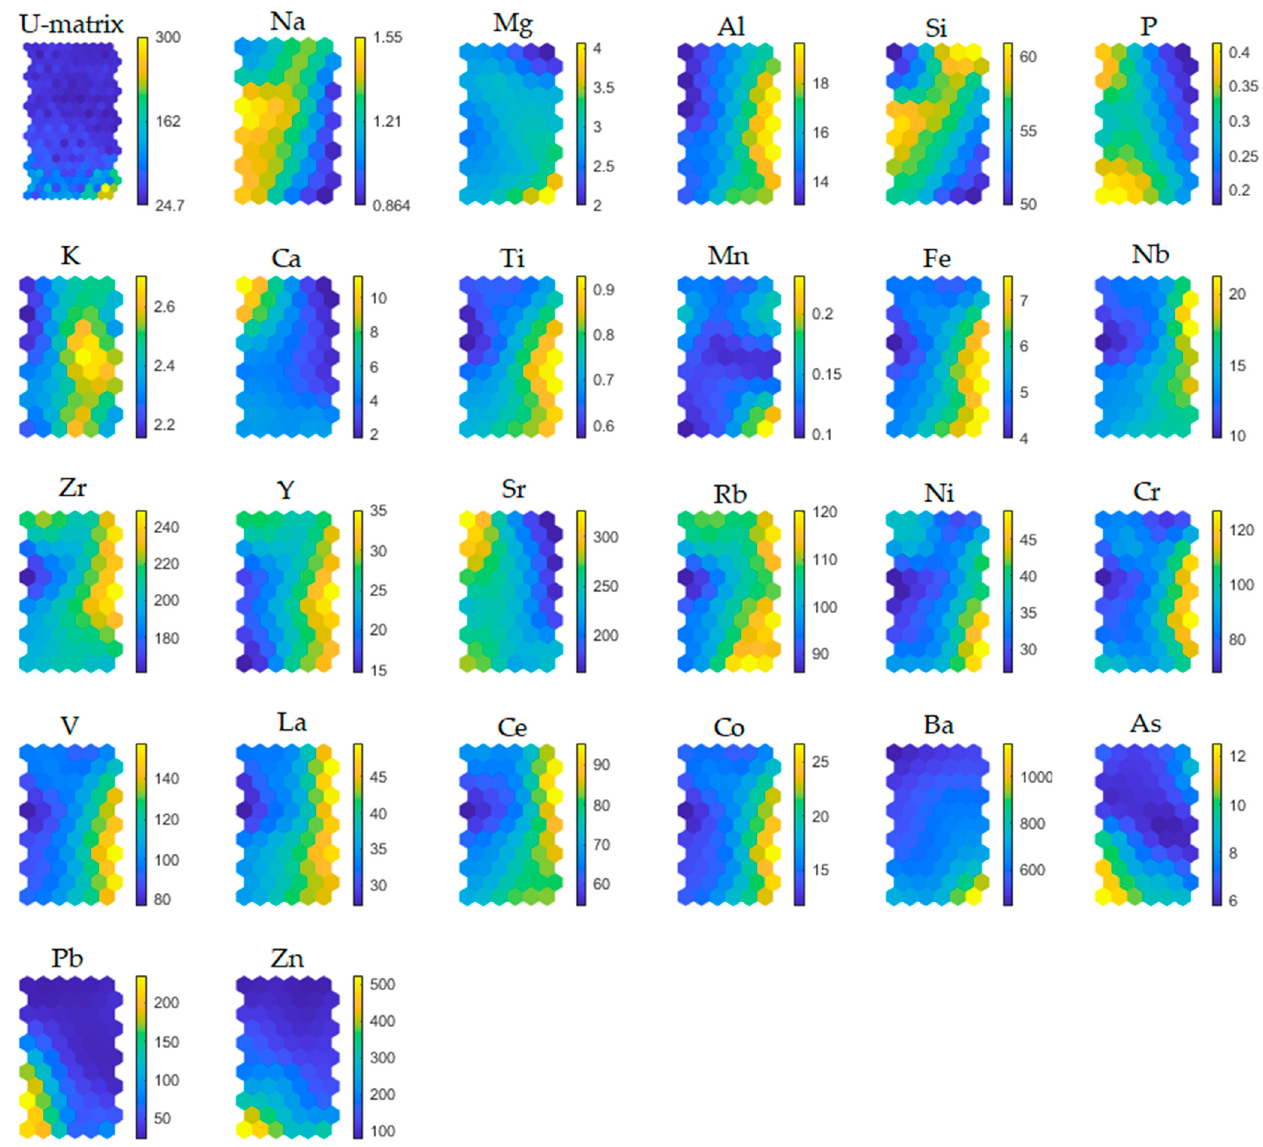
Figure 2. Component planes for all sampling sites and parameters. U-matrix visualizes distances between neighbouring map units and helps to identify the cluster structure of the map. High values of the U-matrix indicate a cluster border, uniform areas of low values indicate clusters themselves; each component plane shows the values of one variable in each map unit. Both grey-tone pattern and grey-tone bar labelled as “d” deliver information regarding compounds/element abundance calculated through the SOM learning process.